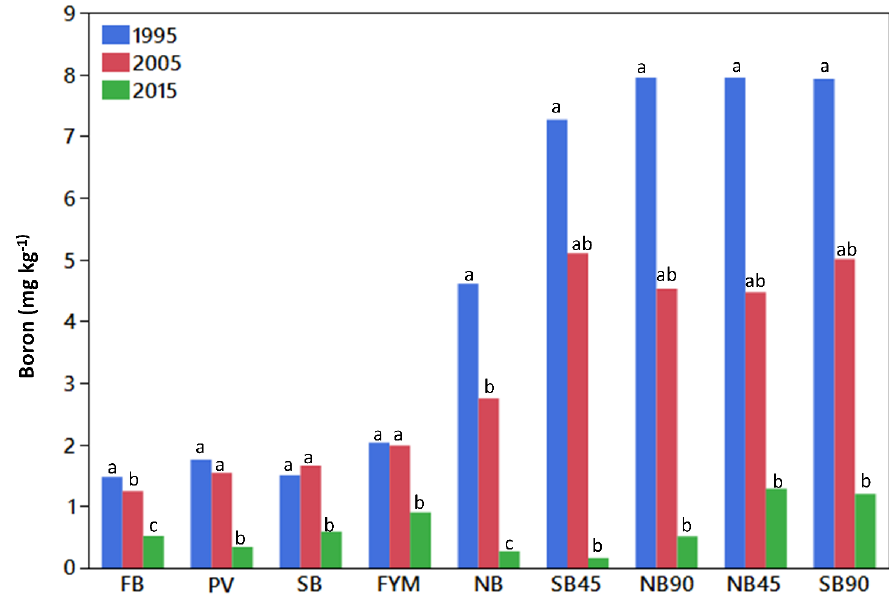
Figure 2. Mehlich III extractable boron dynamics in upper 10-cm soil surface over 20 years in Crop Residue Long-term Experiment (CR-LTE), Adams, OR. NB = No burn, SB = spring burn, FB = fall burn, GP = grass pasture, FYM = farmyard manure, and PV = pea vine. 0, 45, 90 accompanied by NB, SB, and FB represents rates of N applied at 0 kg ha − 1 , 45 kg ha − 1 , and 90 kg ha − 1 , respectively. Means sharing the same letter are not significantly different at 5% significance level.